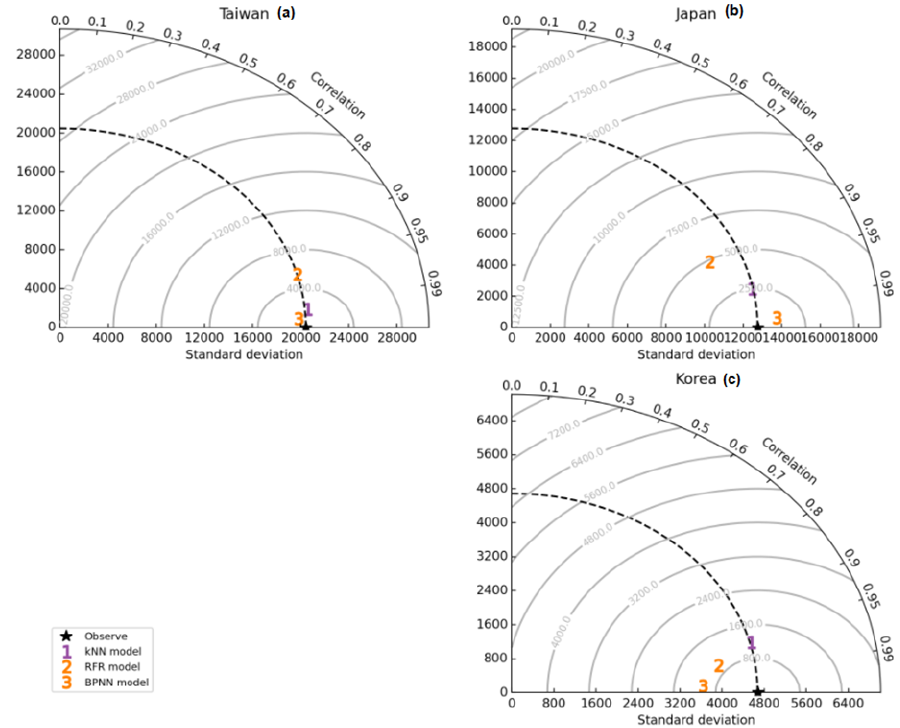
Figure 6. Taylor diagram representing the best performance of BPNN, RFR, kNN models of ( a ) labor exports to Japan, ( b ) labor exports to Taiwan, ( c ) labor exports to Korea.